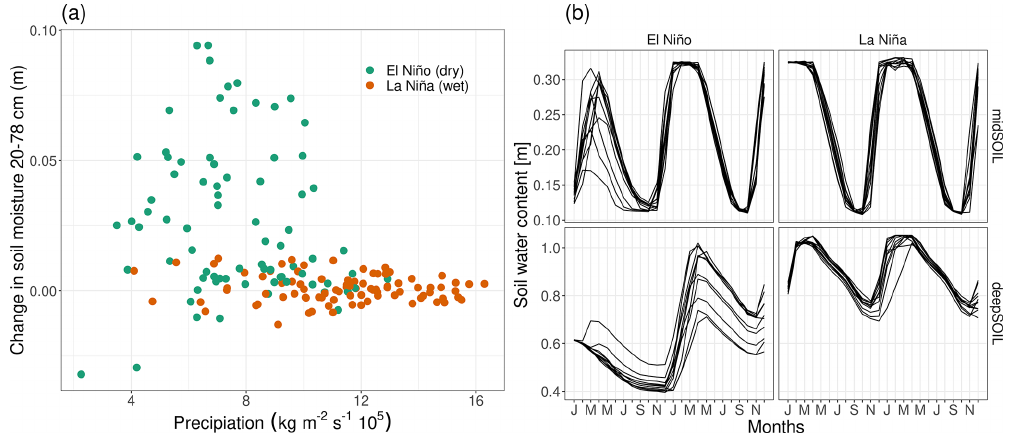
Figure 9. Soil water dynamics of different ENSO states in the Amazon Basin at 8 ◦ S, 54 ◦ W. (a) Relationship between February precipitation and change in soil moisture from February to March. (b) Soil water content of the 11-member ensemble simulation for one specific El Niño and La Niña year (midSOIL and deepSOIL are the moisture content at 19–78 and 79–268cm,